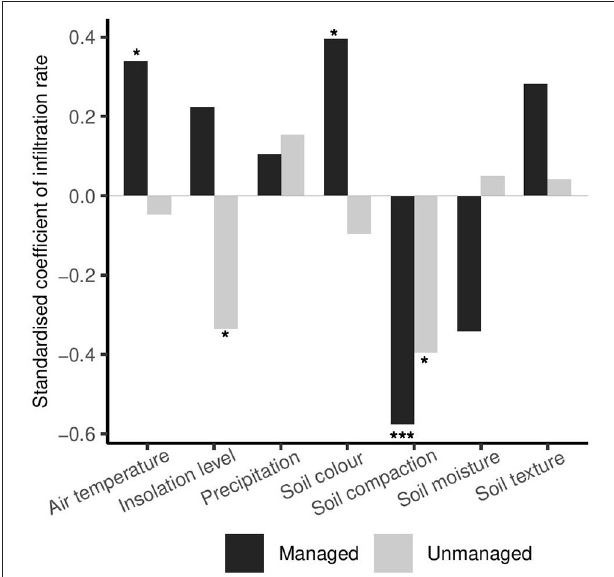
FIGURE 2 | Standardized coefficients ( z score: z = (x– µ )/ σ ) of binary infiltration rate in the managed (black) and unmanaged (gray) logistic regression models in response to each of the model’s independent variables: average daily air temperature, location of sample site relative to level of insolation, average daily precipitation, soil color, soil compaction, average soil moisture, and soil texture. Positive standardized coefficients signify a positive relationship; negative coefficients denote a negative relationship between the independent variable and the likelihood of high infiltration rates ( ≥ 1.75 mL/min). Asterisks denote variables that were significant predictors of high infiltration rate in each model ( * < 0.05, *** < 0.001; Table 1